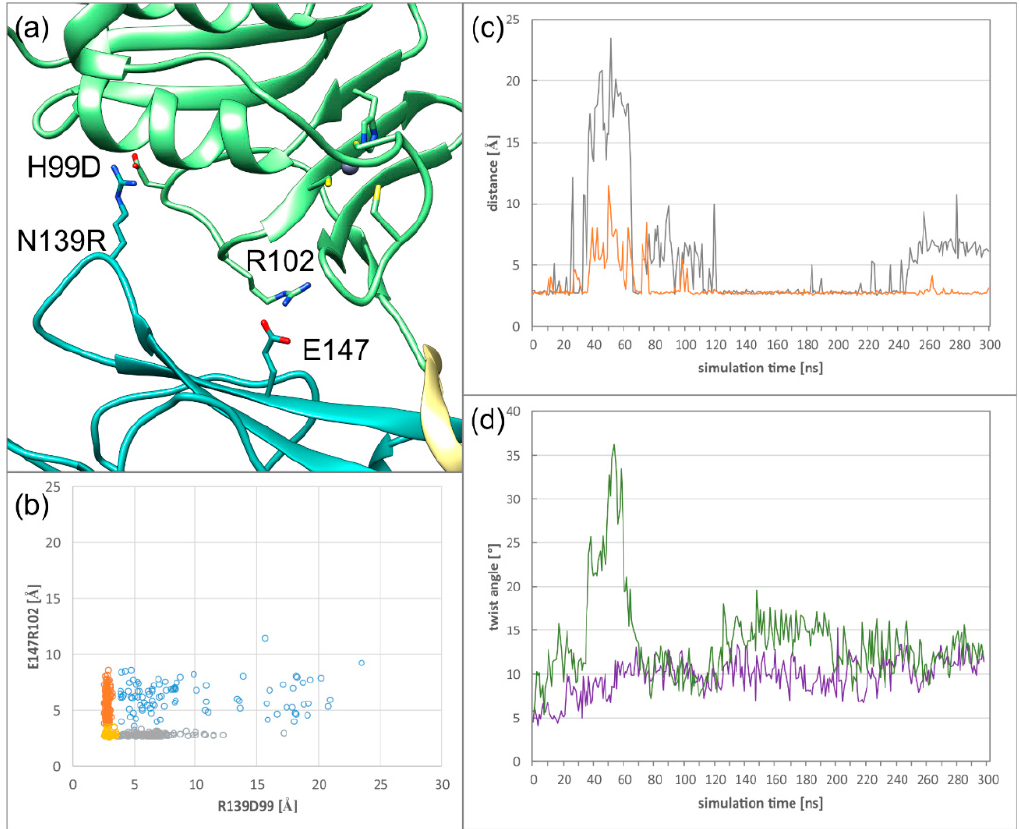
Figure 6. ( a ) Close view of the secondary interface of the mutant HCMV NEC, highlighting the salt bridges R102E147 and R139D99. ( b ) Distribution of the stability of the salt bridge E147R102, which is already present in the wildtype structure, against the additional salt bridge R139D99 created by mutation. ( c ) Plot of the distance of the salt bridges R139D99 (grey) and E147R102 (orange) versus simulation time (run 2). ( d ) Twist angle of both simulations run of the mutant HCMV NEC (run 1, purple; run 2, green).